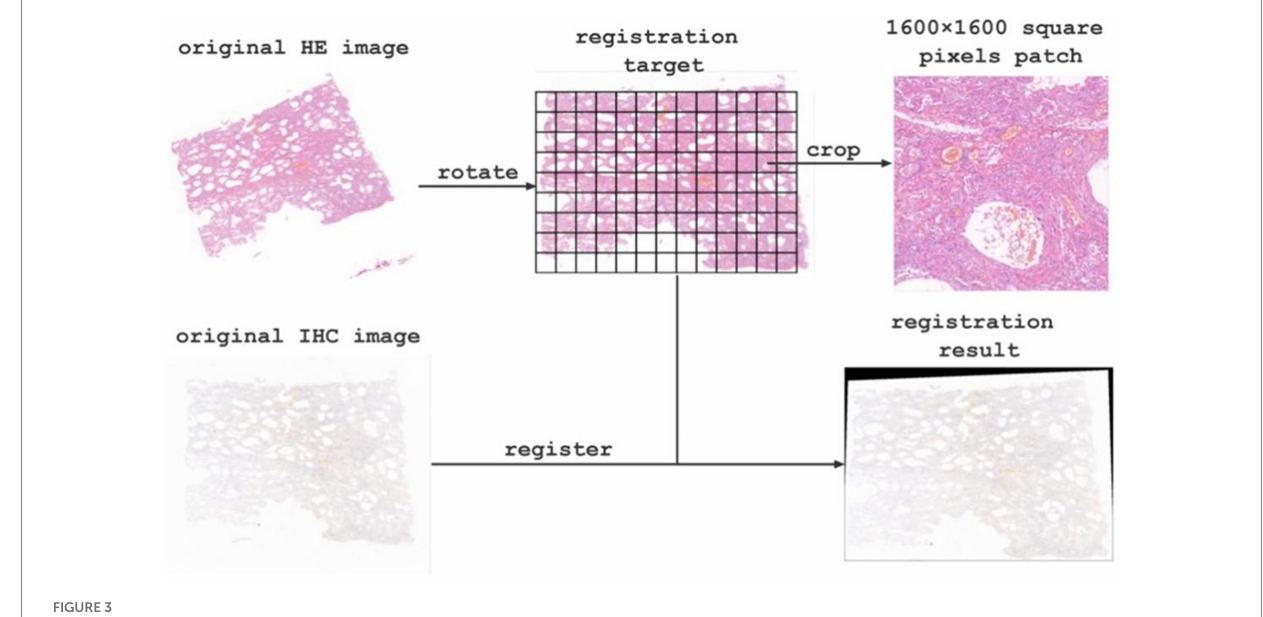
FIGURE 3 Image registration and cropping